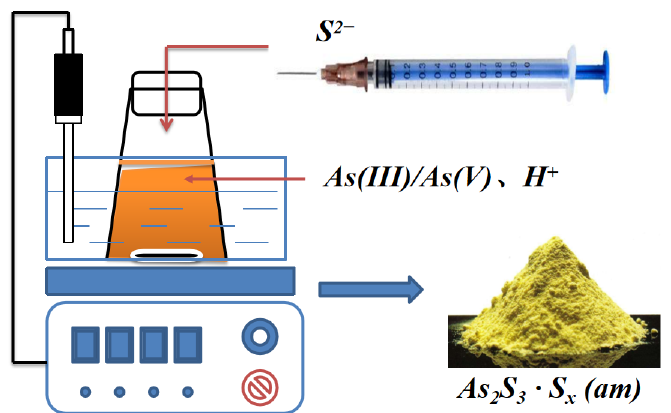
Figure 1. Experimental setup for the sulfide precipitation